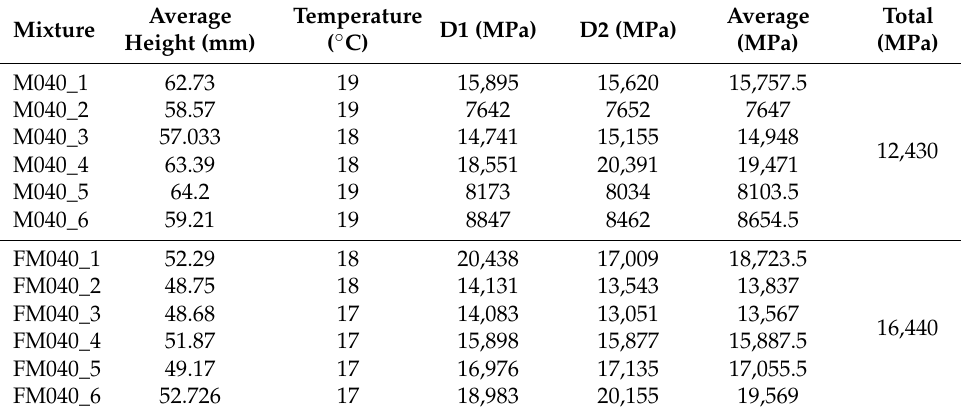
Table 5. Indirect tensile stiffness modulus results.